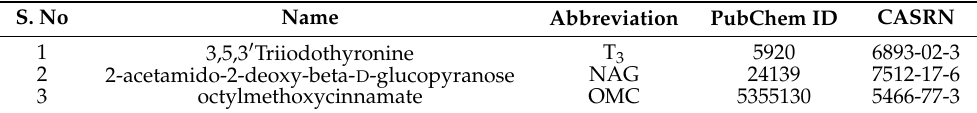
Table 1. Nomenclature, commonly used abbreviations, PubChem IDs and the Chemical Abstracts Ser- vice Registry Number (CASRN) of ligands for molecular docking studies with the thyroid stimulating hormone receptor (TSHR) and thyroid hormone receptor alpha (TRH α ).